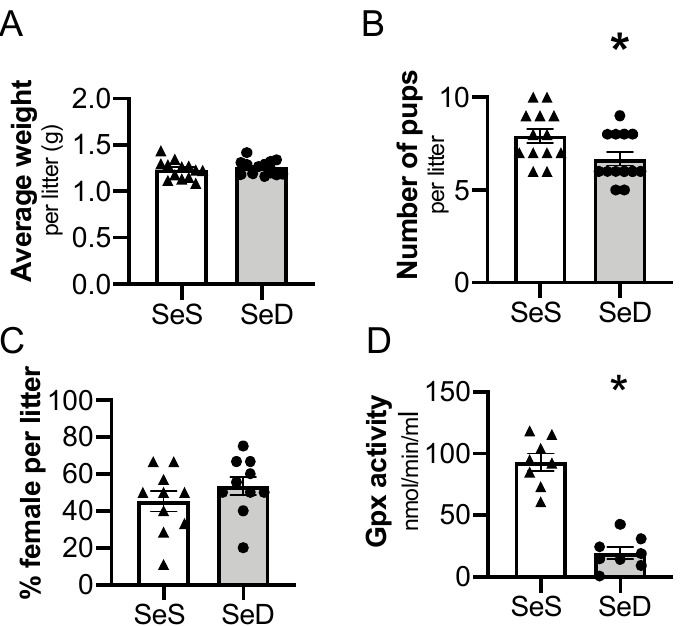
Figure 2. Maternal selenium (Se) deficiency is associated with decreased litter size but similar weight after birth. C57Bl/6 mice were placed on diets that differed only in Se content, either 0.4 ppm or <0.01 ppm of sodium selenite. Breeding was initiated after 2–4 weeks on diets and natural delivery was allowed. ( A ) Neonatal pup weight per litter on day of birth, ( B ) number of pups per litter on day of birth, ( C ) ratio of females per litter, ( D ) plasma glutathione peroxidase activity level by oxidation of NADPH per minute. Each data point represents either a female or male from each litter; each individual point is an average of two mice. Triangles are SeS data points and circles are SeD data points. N = 4–13 litters for all groups. Data are presented as mean ( ± SEM), * p < 0.05 vs. SeS control, by two-sided t -test.